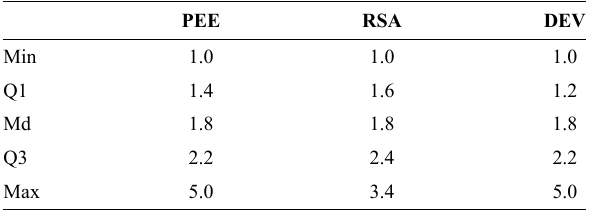
Table 1 - Descriptive data on the burnout dimensions of the total number of athletes ( n = 100).